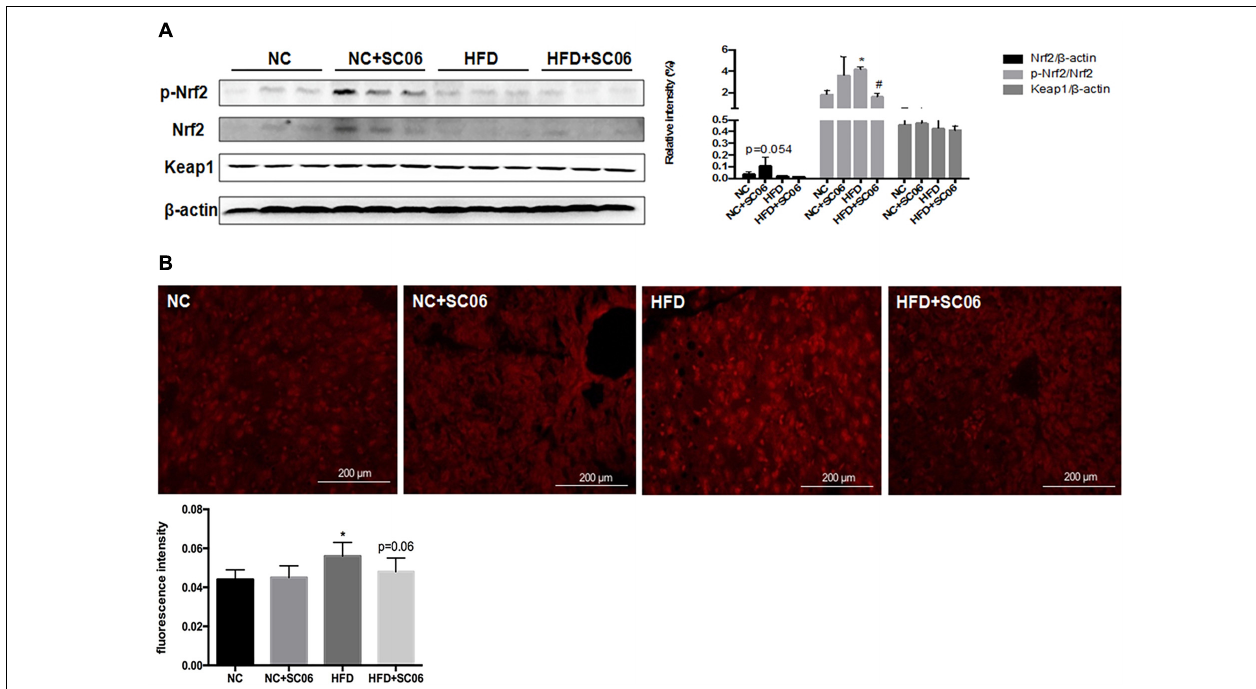
FIGURE 4 | SC06 regulated Nrf2/Keap1 signaling pathway and ROS level. (A) Total protein levels of Keap1 and β -actin as well as the phosphorylated and total protein levels of Nrf2 in mice livers were determined using Abs recognizing phospho-specific or total protein, (B) ROS frozen sections. Fluorescence intensity was quantified by ImageJ software. Results are expressed as means ± SD. Differences between groups were determined by one-way ANOVA followed by Tukey’s t -test ( n = 6). Significant differences between HFD versus ND are indicated as ∗ p < 0.05. Significant differences between HFD versus HFD+SC06 are indicated as # p <